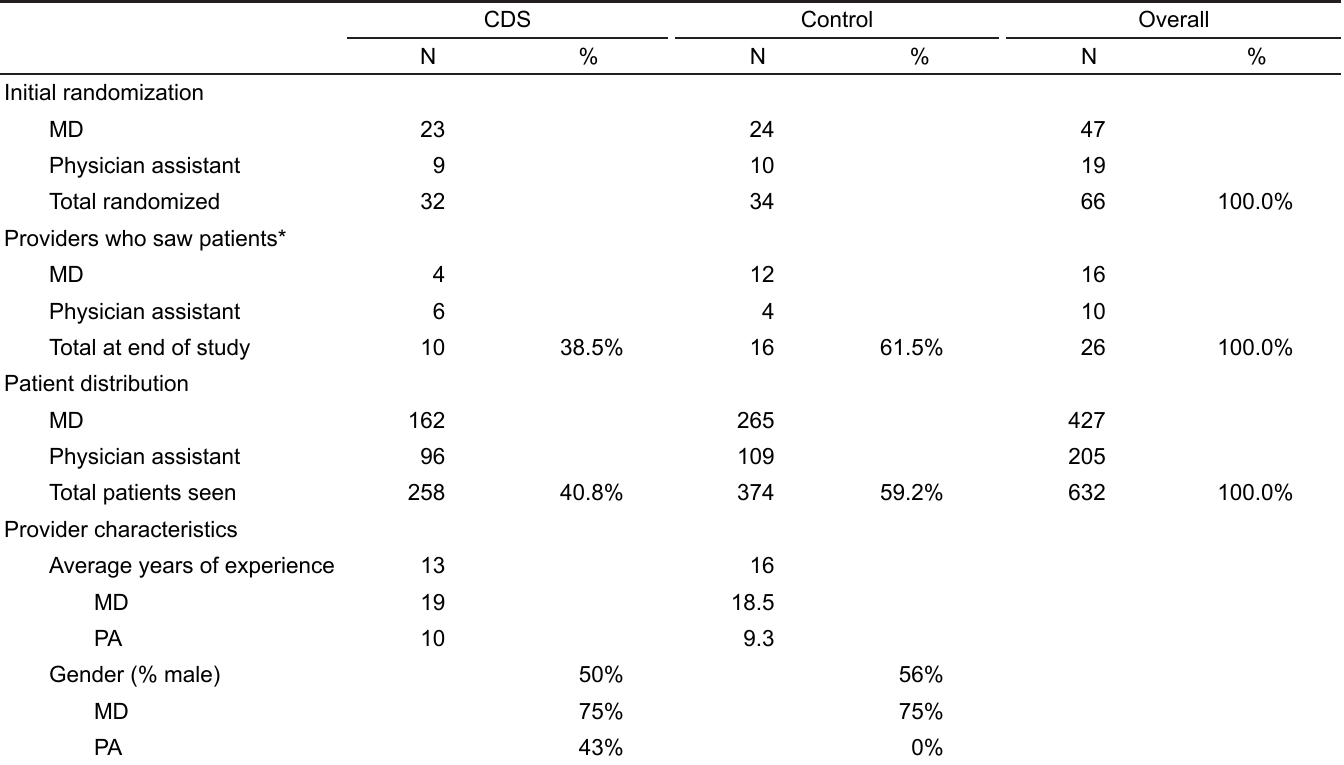
Table 1. Provider characteristics by group and total in study of efficacy of clinical decision support, based on the Ottawa Ankle Rules, to curb unnecessary foot and ankle